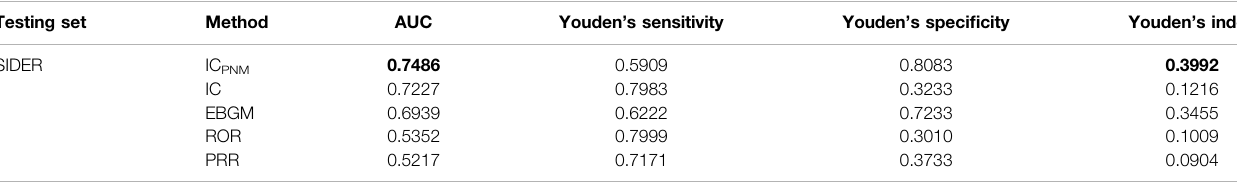
TABLE 4 | Results of performance of different signal detection algorithms using cross validation and FAERS 2014 – 2019Q2 data. Testing set